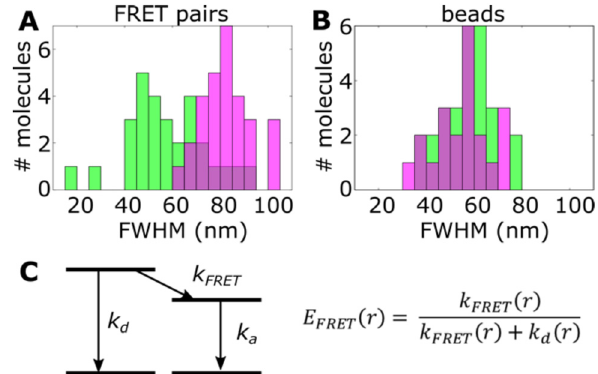
Figure 7: (A) Histogram of the FWHM obtained from different FRET pairs, where green and magenta correspond to donor and acceptor emitters, respectively. (B) Corresponding histogram obtained on 20 nm beads measured using the same antenna and under similar experimental conditions. (C) Schematics of the FRET process, where k a (acceptor emission rate) depends on the competition between k d and k FRET